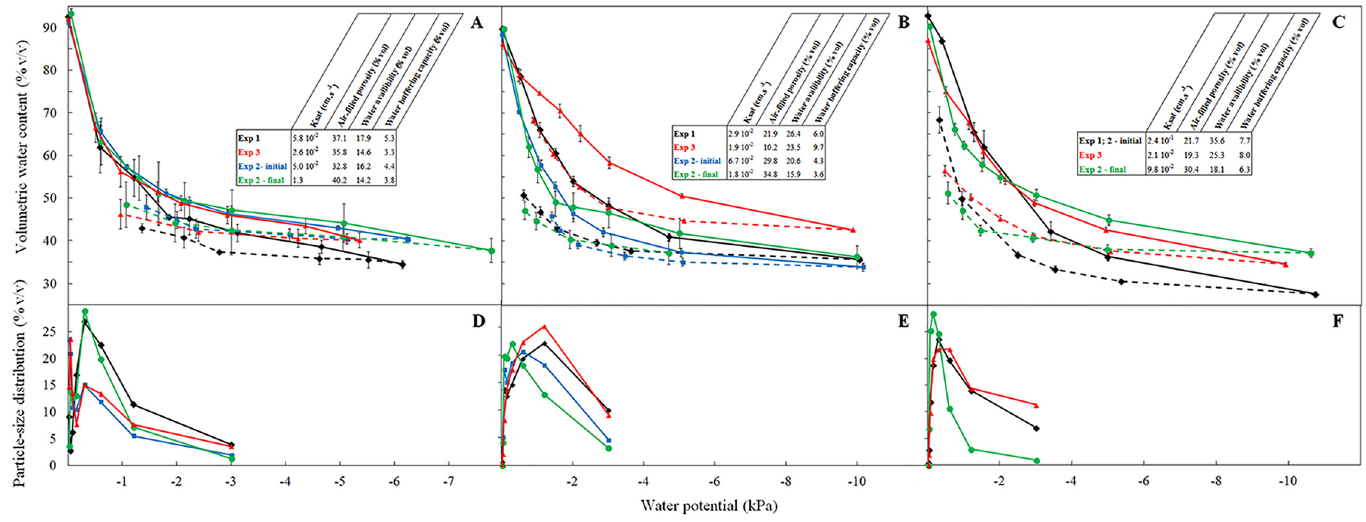
Fig 1. Water retention curves ( A, B, C ) and calculated water potential corresponding to size distribution ( D, E, F ) of CF ( A, D ), AB ( B, E ) and PS25 ( C, F ) substrates. Each point is the mean (n = 3) with standard deviation (SD). For each WP value (kPa), the corresponding particle size (mm) are as follow: WP = -3, [0,25; 0,1[; WP = -1.2, [0.5; 0.25[; WP = -0.6, [1.0; 0.5[; WP = -0.3, [2.0;1.0[; WP = -0.15, [4.0; 2.0[; WP = -0.08, [8.0; 4.0[; WP = -0.04, [16.0; 8.0[; WP = -0.02, >